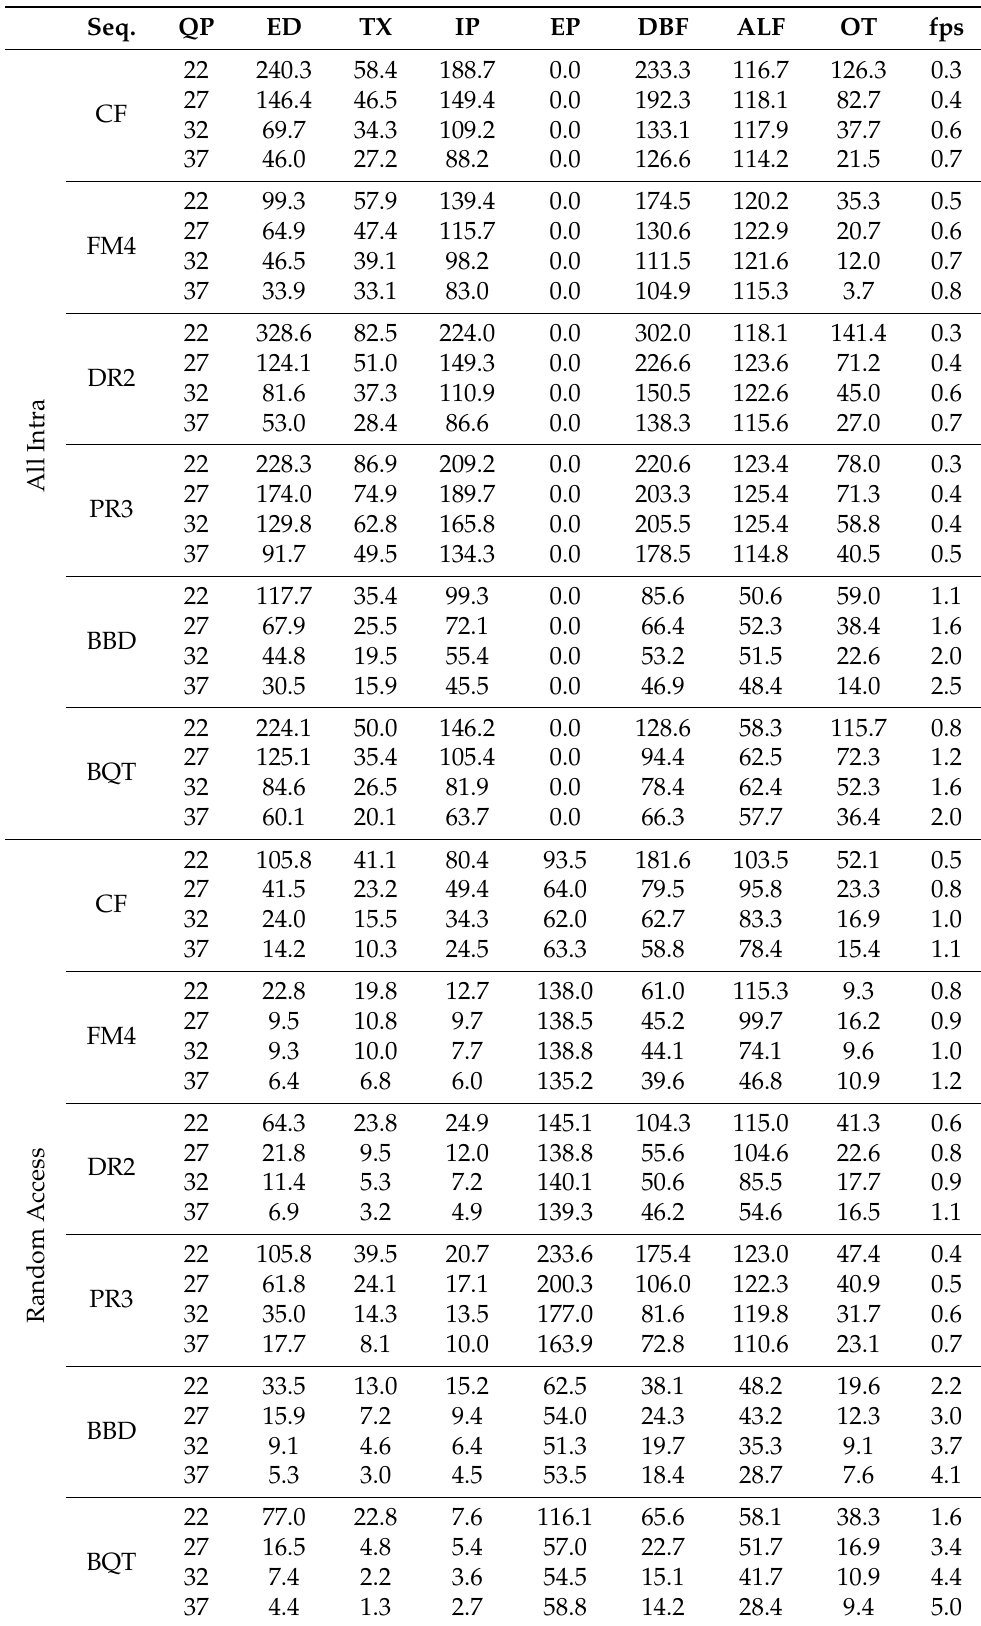
Table 3. Processing times (in secs) for each decoding block and global fps achieved over the EGPP.